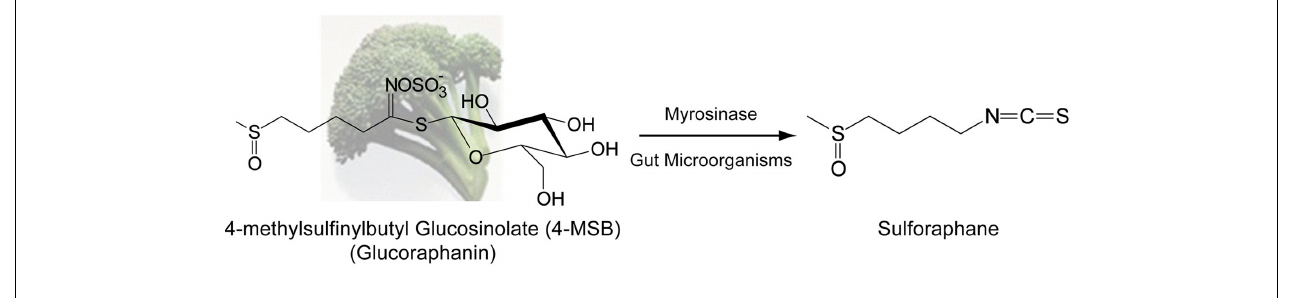
the hydrolysis of GR to the isothiocyanate sulforaphane (SF). Additionally, microorganisms within the human gut can catalyze hydrolysis of GR to SF. Contribution of gut microorganism catalysis is important in SF production due to inactivation of myrosinase by common culinary preparation of broccoli via heating, which inactivates